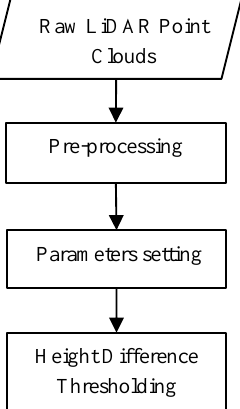
Figure. 1. Flowchart of the proposed method for filtering of LiDAR point clouds.